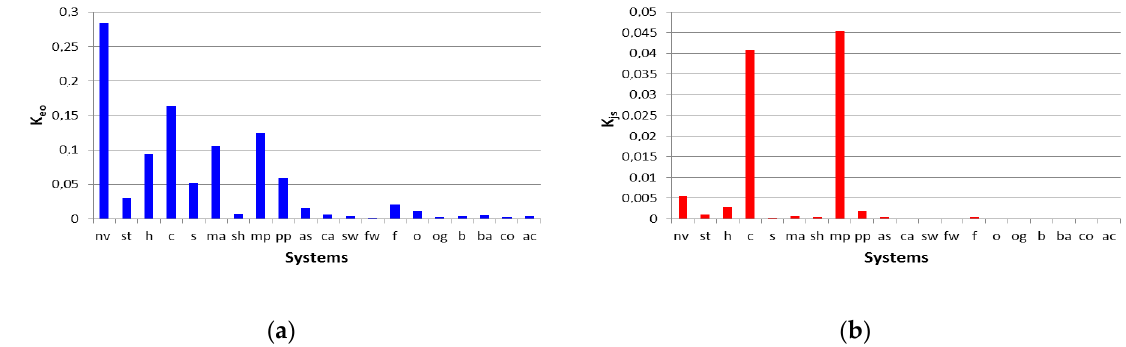
Figure 1. Results of the estimation of the rate of frequency of adverse events in functional systems of the seagoing vessels under analysis ( a ); estimates of the unit cost indicator of adverse events in functional systems of the surveyed seagoing vessels ( b ): nv —navigating, st —steering, h —hull, c —cargo, s —safety, ma —mooring and anchoring, sh —socio-hotel, mp —main propulsion, pp —power plant, as—auxiliary